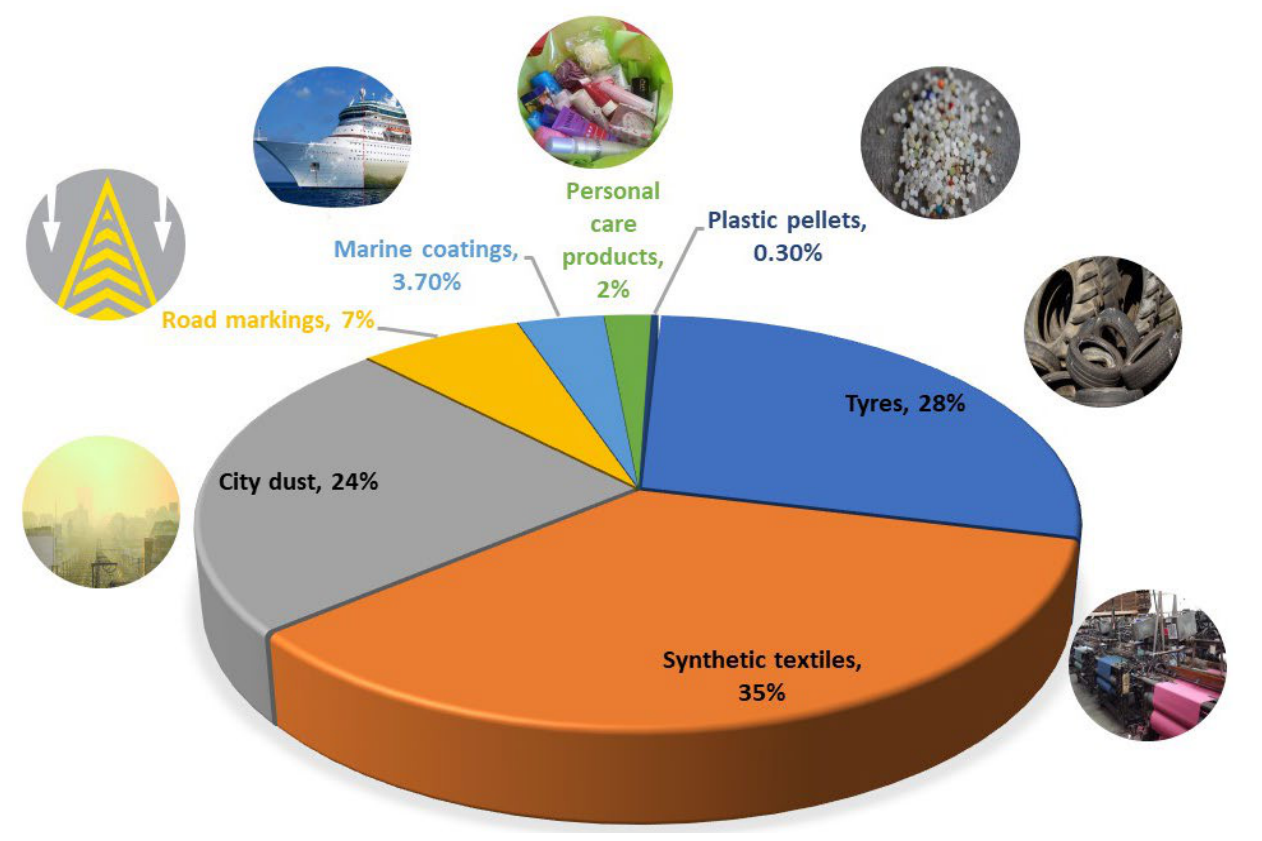
Figure 1. Sources of primary and secondary MPs [23].